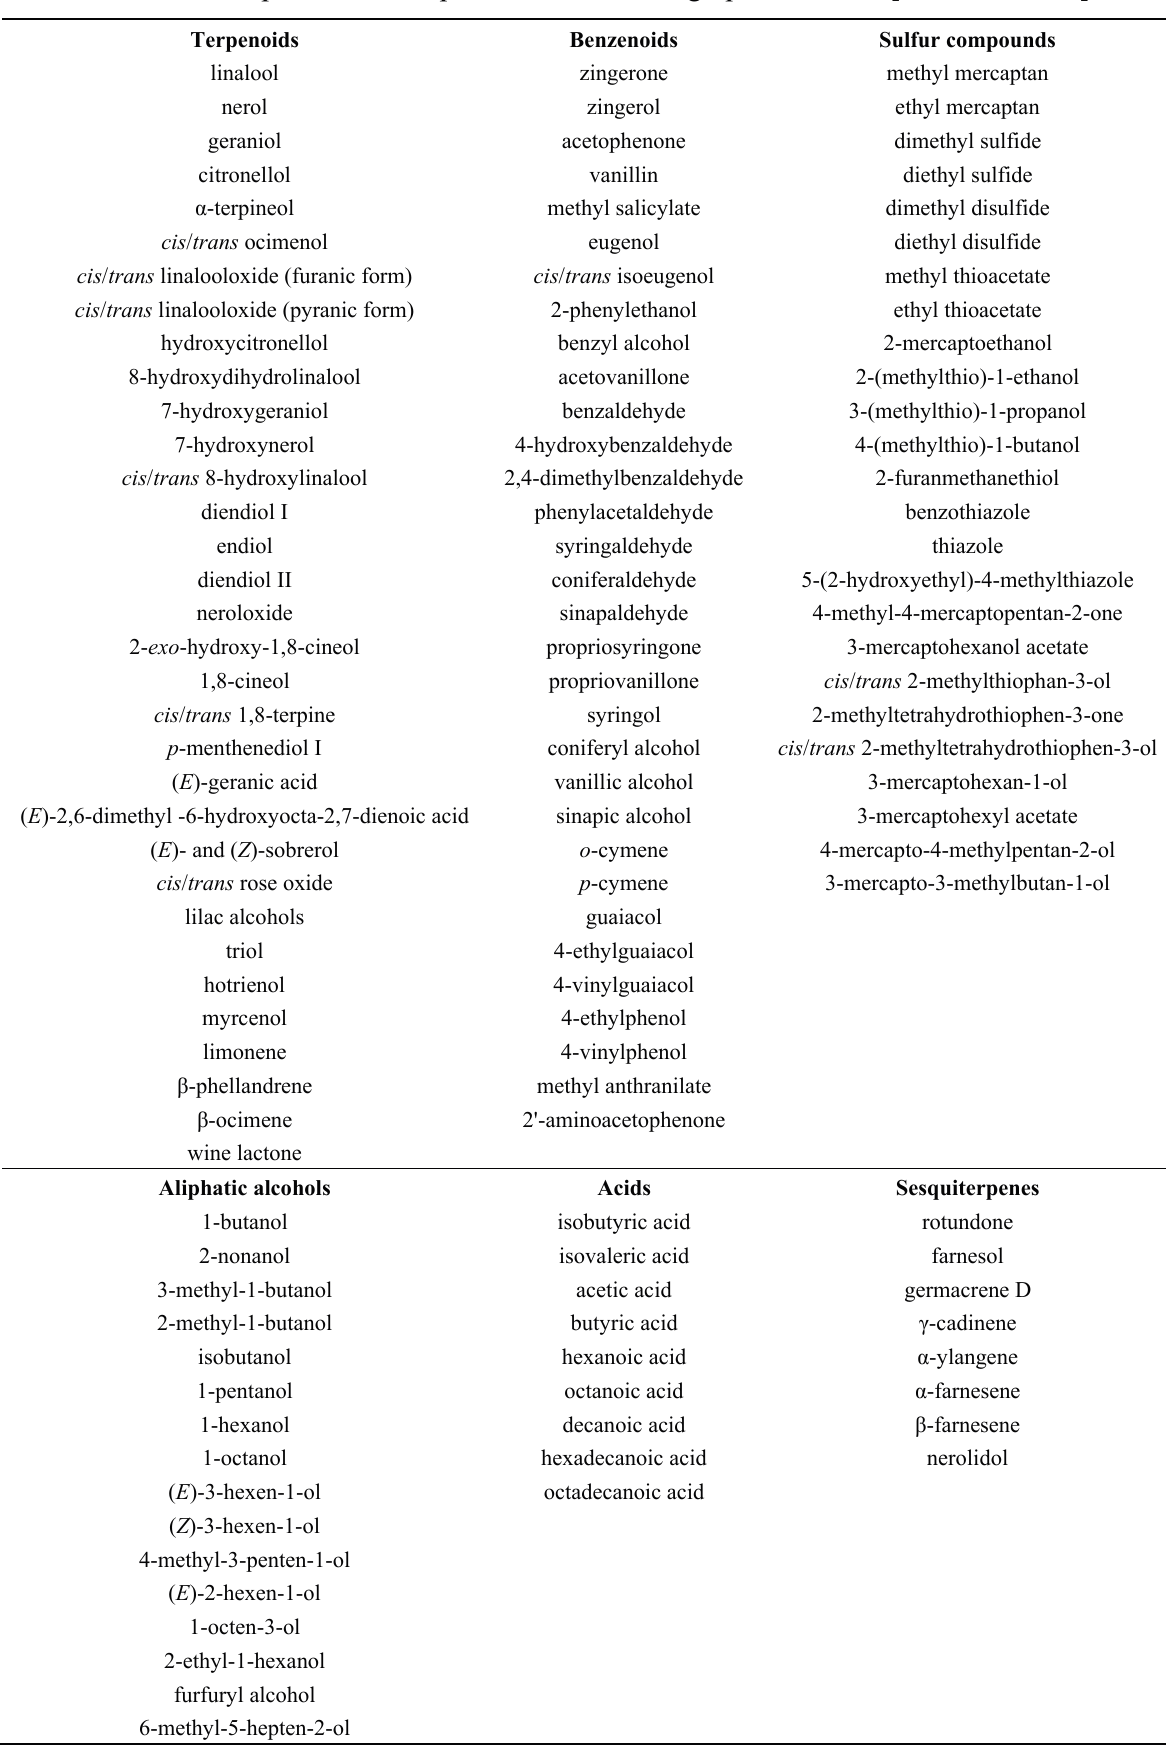
Table 1. Principal aroma compounds identified in grapes and wine